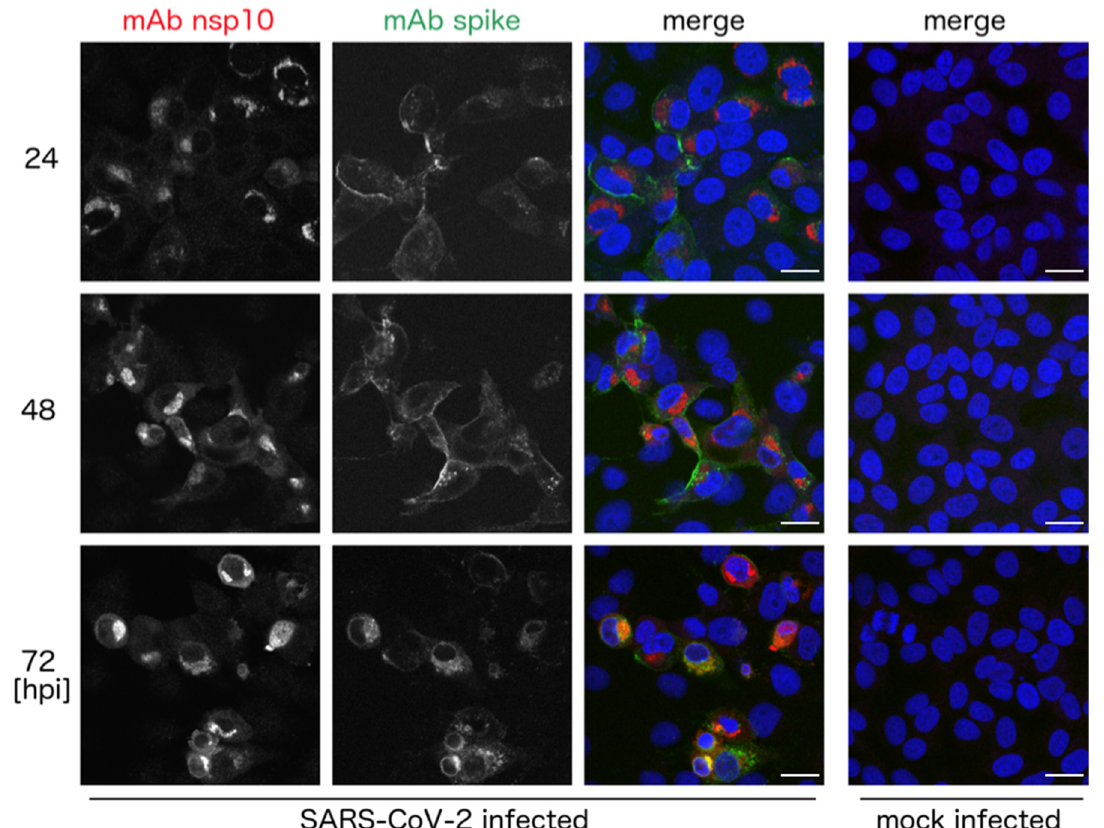
Figure 2. Expression of the nsp10 and spike proteins in the SARS-CoV-2-infected cells. Vero cells were infected with the SARS-CoV-2 strain hCoV-19/Czech Republic/NRL_6632_2/2020 , fixed at indicated times and immunostained with anti-nsp10 and anti-spike antibodies. Expression of nsp10 (red) and spike (green) proteins was analyzed by confocal microscopy. Nuclei were stained with Hoechst 33342 (blue). Scale bars represent 20 µm. Hpi, hours post infection.